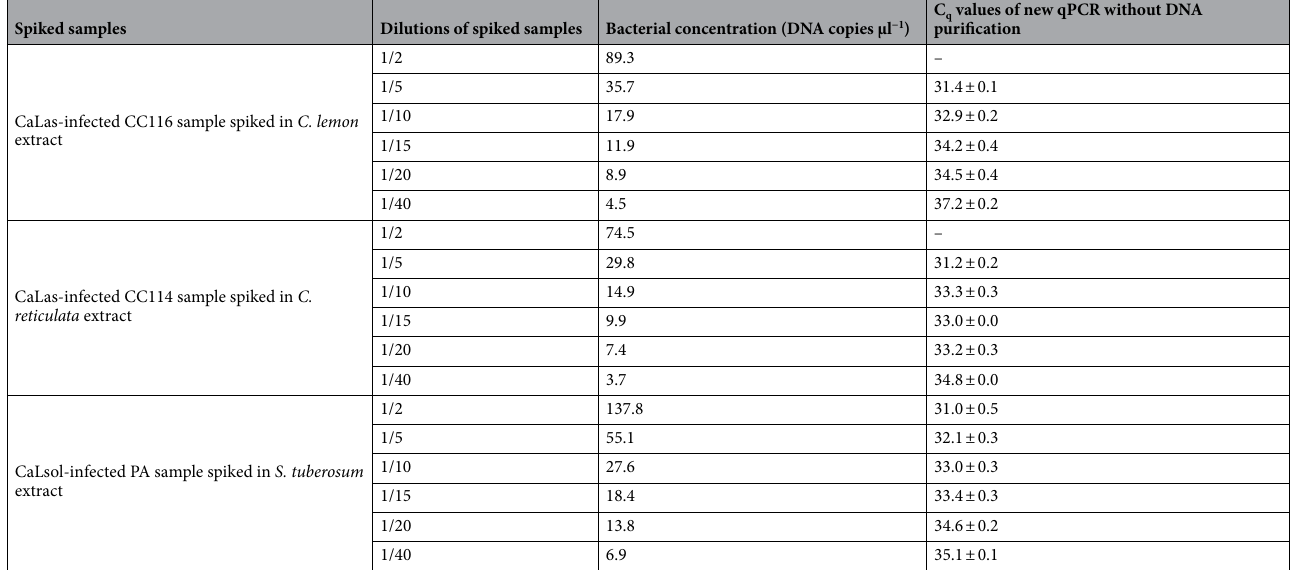
Table 1. Analytical sensitivity of the new qPCR protocol. Average values (cid:31) X Cq + SE (cid:30) shown come from triplicate PCR reactions from each template. Spiked samples were prepared by serially diluting CaLas-infected C. lemon and C. reticulata crude extracts or CaLsol-infected S. tuberosum crude extract in respective non- infected crude extracts (v/v). The number of DNA copies per microliter was calculated by the new qPCR method from DNA purification.